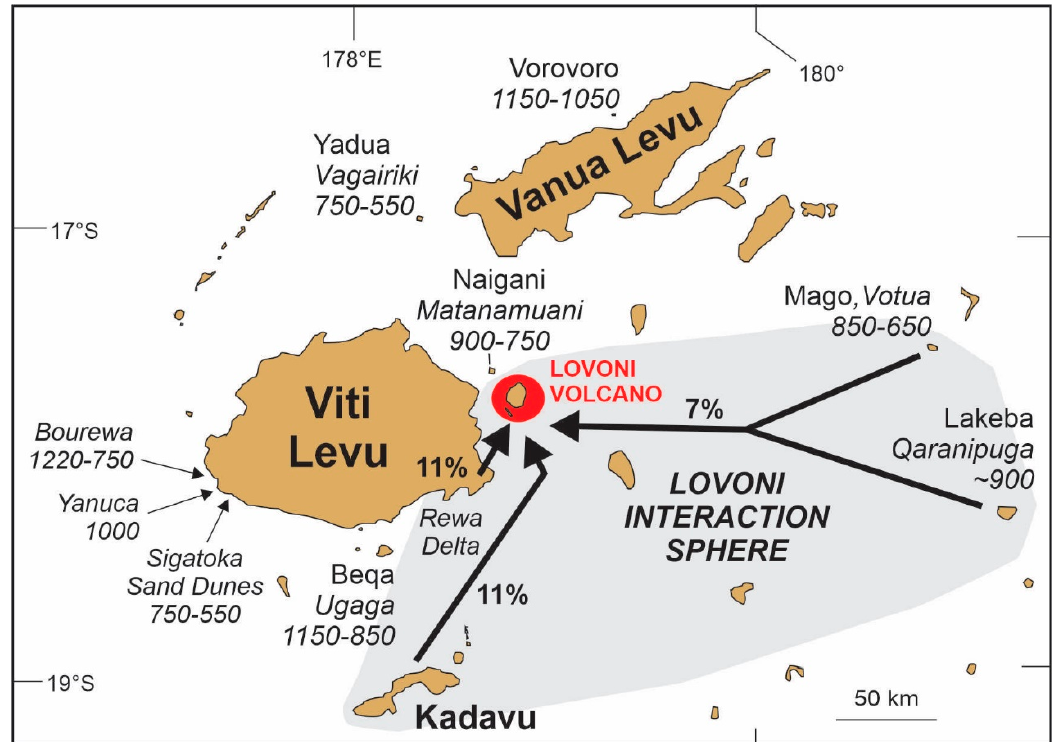
Figure 5. The proposed Lovoni interaction sphere in Fiji which existed during the Lapita-era occupation of Naitabale (Moturiki Island) in the southwest part of the Lovoni Volcano within the period 3170 cal BP (1220 BCE) to 2353 cal BP (403 BCE). Ceramic sand-temper analyses suggests there was regular interaction with Lapita communities (none of which have been certainly identified) in the Rewa Delta (southeast Viti Levu Island) and on Kadavu Island; there was also some moderate interaction with Lapita communities on Lau islands like Lakeba and Mago to the east. Map shows key dated Lapita-era sites elsewhere in Fiji with approximate ages (in years BCE): Bourewa [13,14], Yadua [34], Vorovoro [35], Naigani [16] and others